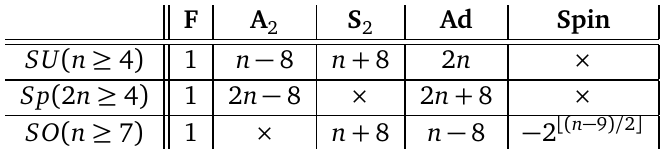
Table 6: Quartic indices of the commonest irreps. The symbol (cid:98) x (cid:99) denotes the floor of x .